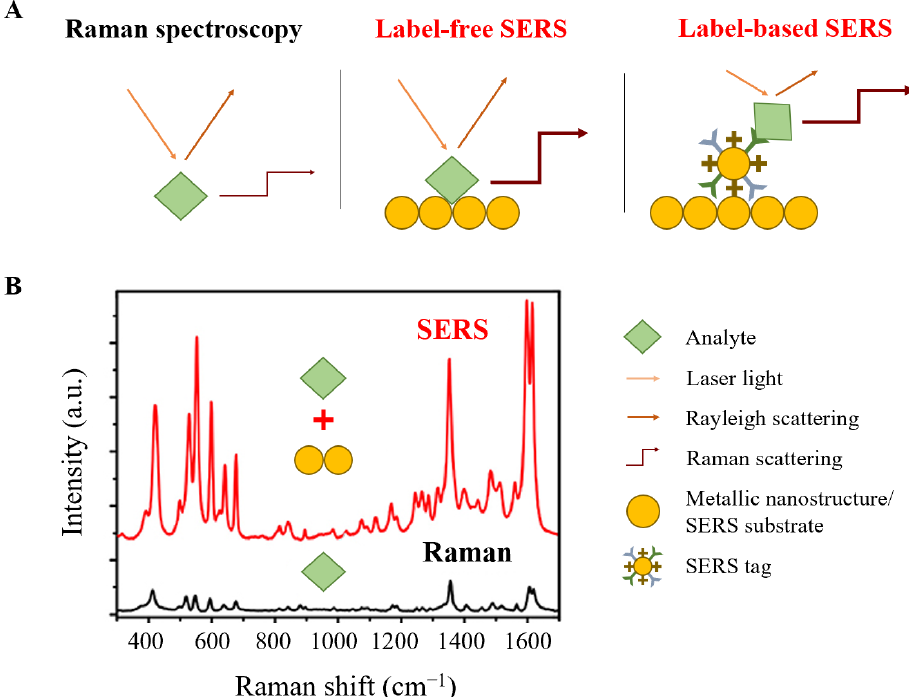
Figure 1. Comparison of Raman spectroscopy and SERS. ( A ) Schematic illustration of Raman spectroscopy, label-free, and label-based SERS. ( B ) Raman (black) and SERS (red) spectrum of pyocyanin. SERS is based on the application of plasmonic gold nanoparticles. Graph visualizes intensity differences between Raman and SERS signals of pyocyanin [5].